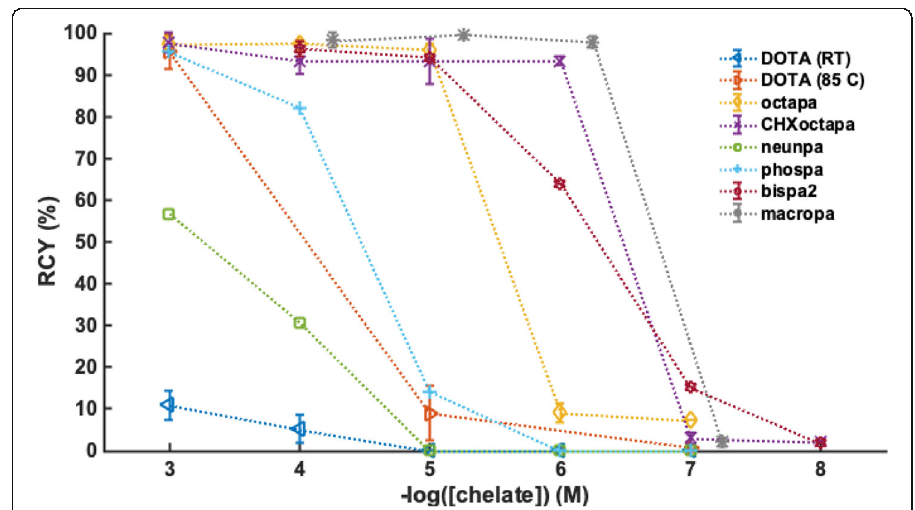
Fig. 4 Radiochemical yields (RCY, %) for 225 Ac III radiolabeling reactions of DOTA (RT, 2 h, pH 5.5; 85 °C, 30 min, pH 7, H 4 octapa (RT, 1 h, pH 5.5), H 3 CHX octapa (RT, 1 h, pH 5.5), H 4 neunpa (RT, 1 h, pH 5.5), H 6 phospa (RT, 1 h, pH 5.5), H 2 bispa 2 (RT, 1 h, pH 5.5) and macropa (RT, 5 min, pH 7) for comparison, at ambient temperature (RT) and ligand concentrations 10 − 3 to 10 − 8